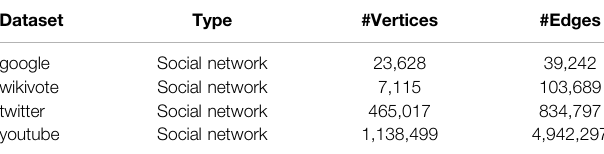
TABLE 1 | Statistics of graph